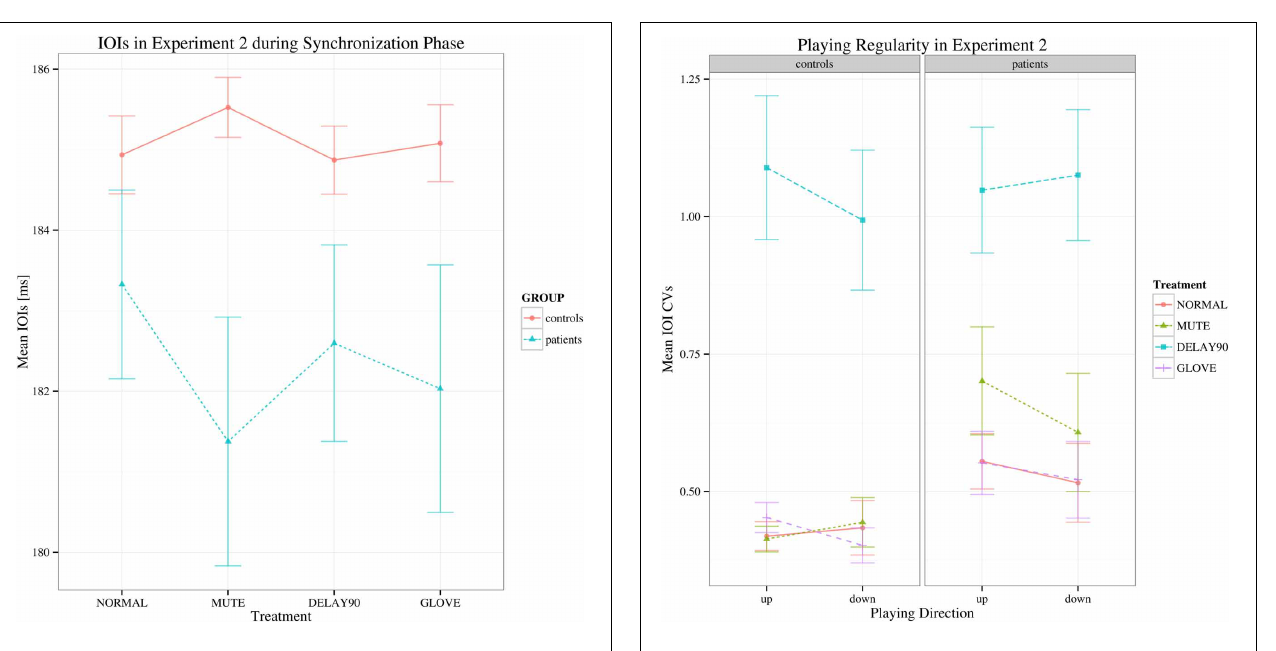
FIGURE 5 | Interaction plot of IOI CVs for the continuation phase of Experiment 2. Error bars denote 95% confidence intervals. symptoms had slightly improved motor control under MUTE